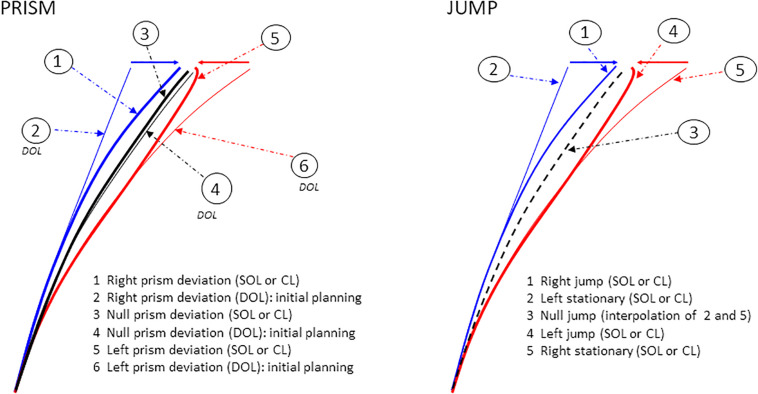
Examples of single hand X–Y trajectories in Prism and Jump experiments. Prism experiment: right (blue), left (red), and null (black) prism deviation. Six hand trajectories are possible. Correction latency refers to the earliest point at which spatiotemporal parameters begin to deviate from reference trajectories. It is measured as the divergence between paths 1 (right prism deviation, SOL or CL) and 2 (initial planning, DOL) for right deviations, and between paths 5 (left prism deviation, SOL or CL) and 6 (initial planning, DOL) for left deviations. Paths 3 and 4 correspond to null prism deviation, under SOL/CL, and DOL respectively. Jump experiment: right (blue), left (red), and null (black) jump deviation. Five hand trajectories are possible. Correction latency corresponds to divergence from reference trajectories, between paths 1 (right jump, SOL or CL) and 2 (left stationary target) for right deviations, and between paths 4 (left jump, SOL or CL) and 5 (right stationary target) for left deviations. Path 3, which corresponds to the null jump, is the linear interpolation of paths 2 and 5. Reference trajectories refer to DOL pointing for Prism perturbation, and to pointing to stationary targets for Jump perturbation.